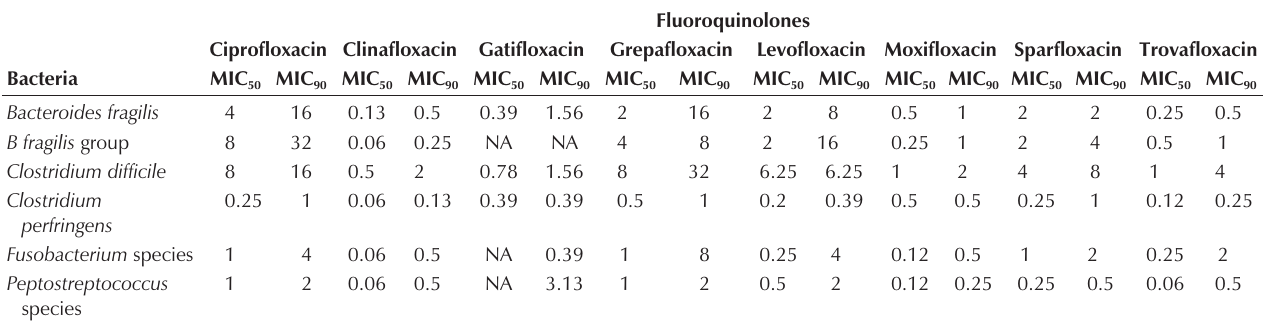
In vitro activity of the new fluoroquinolones and ciprofloxacin against anaerobes